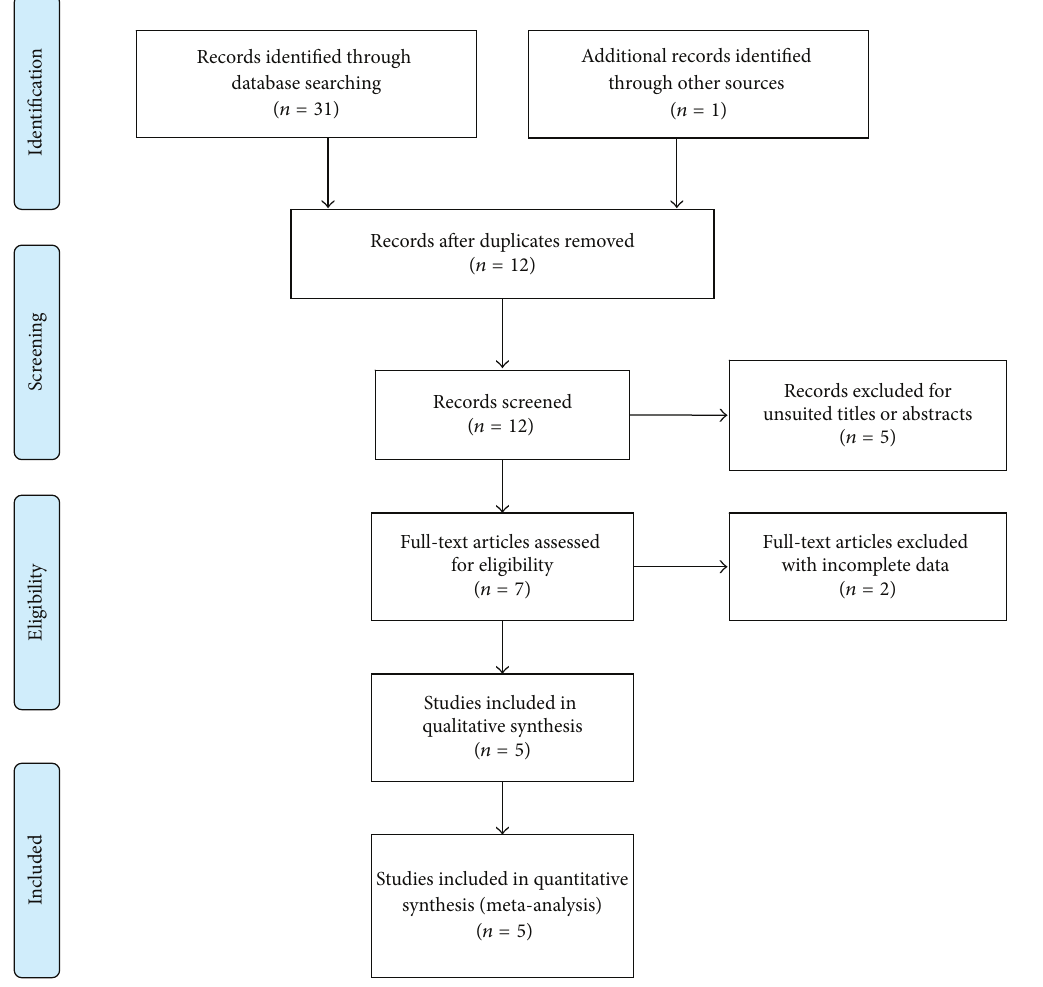
Figure 1: PRISMA flow diagram of studies included in the meta-analysis.